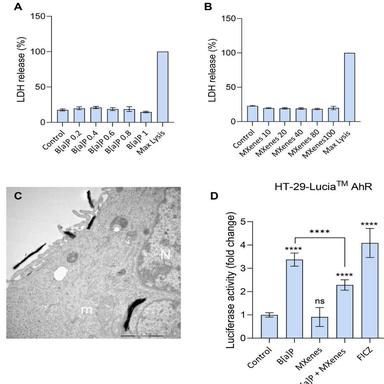
MXenes attenuate BP triggered AhR activation in human cells. (A,B) Cytotoxicity assessment. HT-29 cells were exposed for 24 h to (A) BP, and (B) MXenes. Cell viability was evaluated using the LDH release assay. (C) Cellular uptake. TEM analysis was performed upon exposure of HT-29 cells to MXenes (80 mg/ L) for 24 h (see Fig. S4 for additional images of control cells and exposed cells). Scale bar: 2 μm. m, mitochondria; N, nucleus. (D) AhR activation. Luciferase activity was determined in HT-29-Lucia™ AhR r